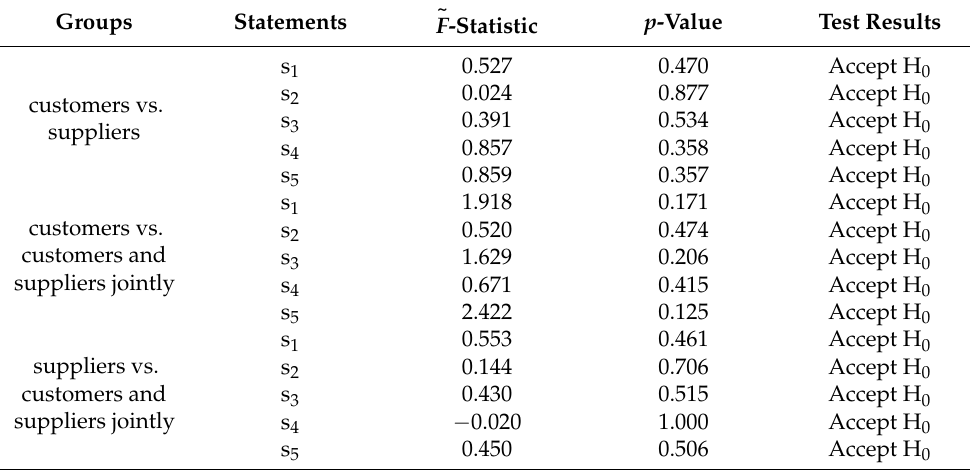
Table 11. Fuzzy ANOVA